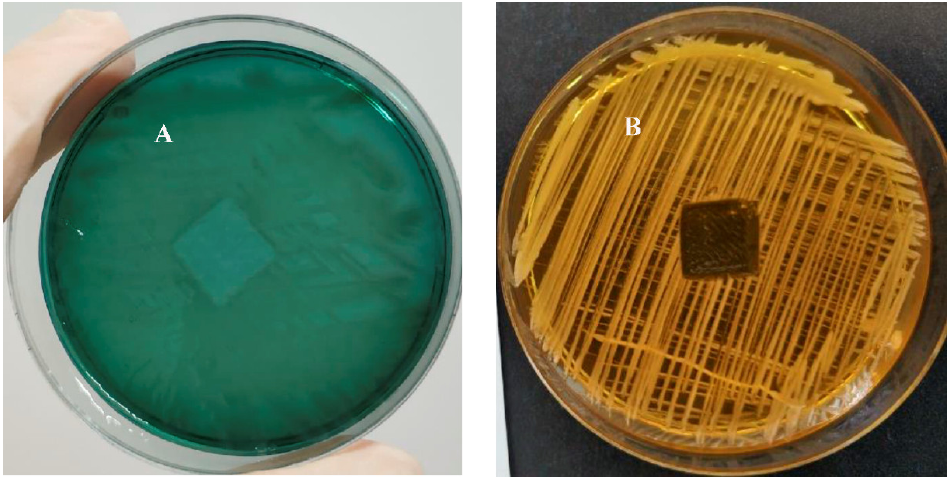
Figure 5. Picture of a zone-of-inhibition-test result of 1% 12a coating plastic sample (PC+); ( A ) zone of inhibition of P. aeruginosa and ( B ) zone of inhibition of S. aureus